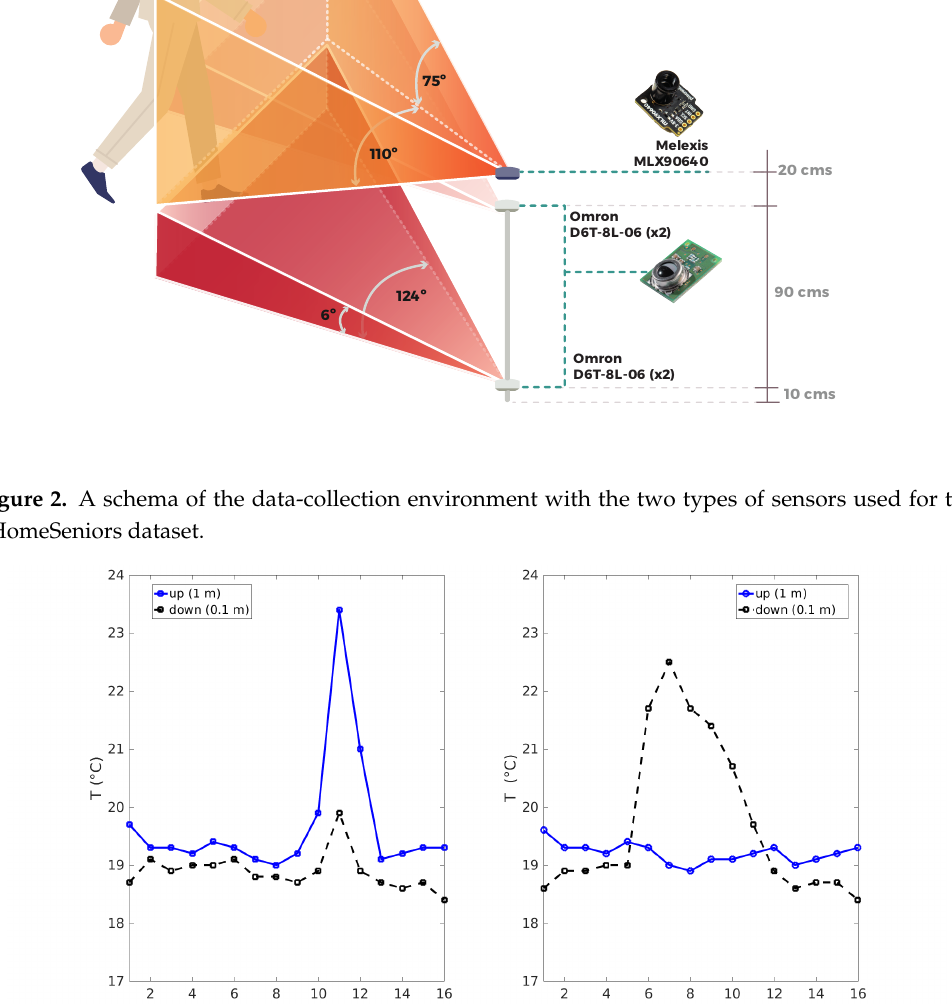
Figure 3. Temperatures detected by the Omron D6T-8L-06 sensor system for a standing body (left) and a fallen body (right): The continuous line corresponds to the 16 pixels placed at 1 meter from the floor and the dashed one corresponds to that at 0.1 m from the